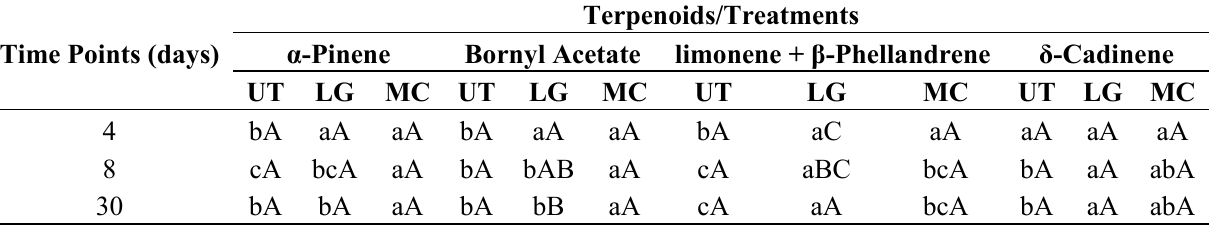
Table 2. Tukey’s tests showed significant differences among comparisons of individual monoterpenes and sesquiterpenes in the xylem of the stem among treatments at each time point and across different time points in individual